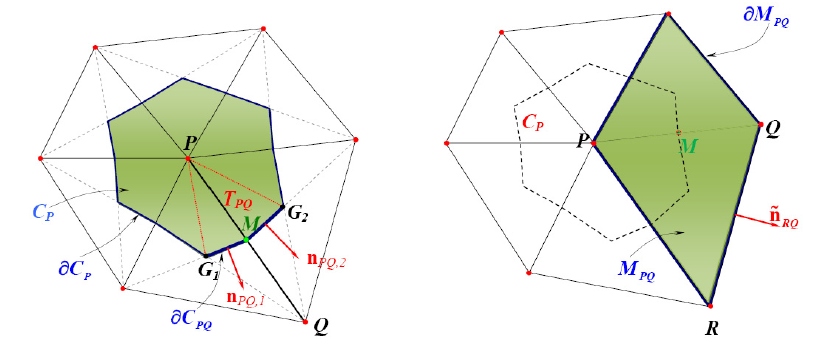
Figure 1. Median-dual computational cell implemented in the FV scheme ( left ) and the computational cell used for the gradient of the divergence in (2) ( right